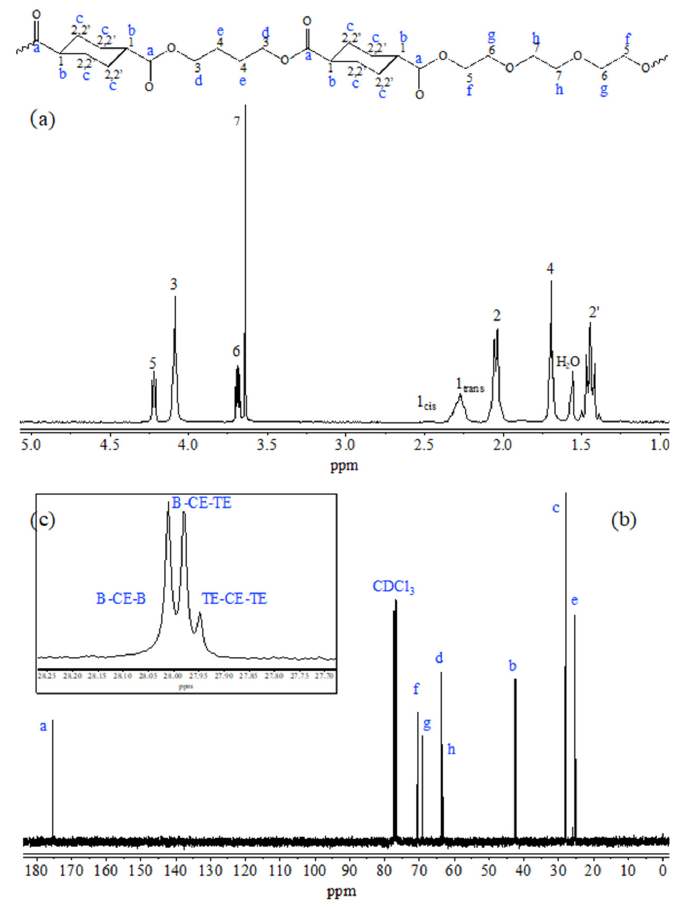
Figure 1. 1 H-NMR ( a ) and 13 C-NMR ( b ) spectra of P(BCE- co -TECE) copolymer with the relative peak assignment. Insert ( c ): magnification of the 28.25–27.70 ppm